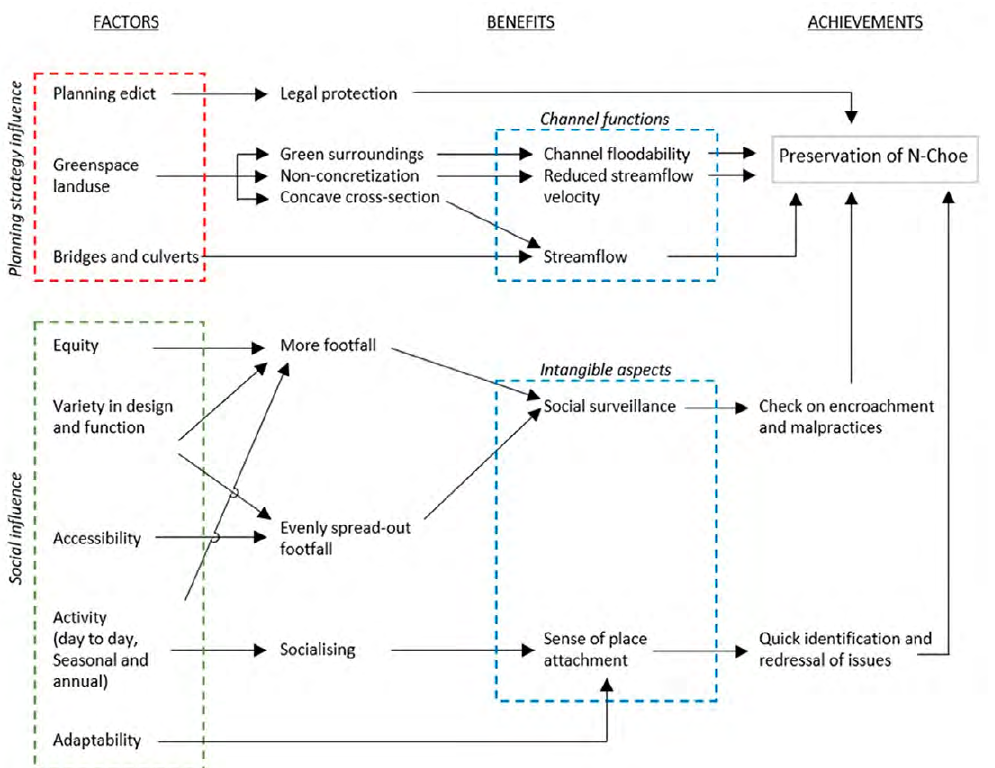
Figure 5. Summary of the contributory factors and their benefits that contribute to the N-choe